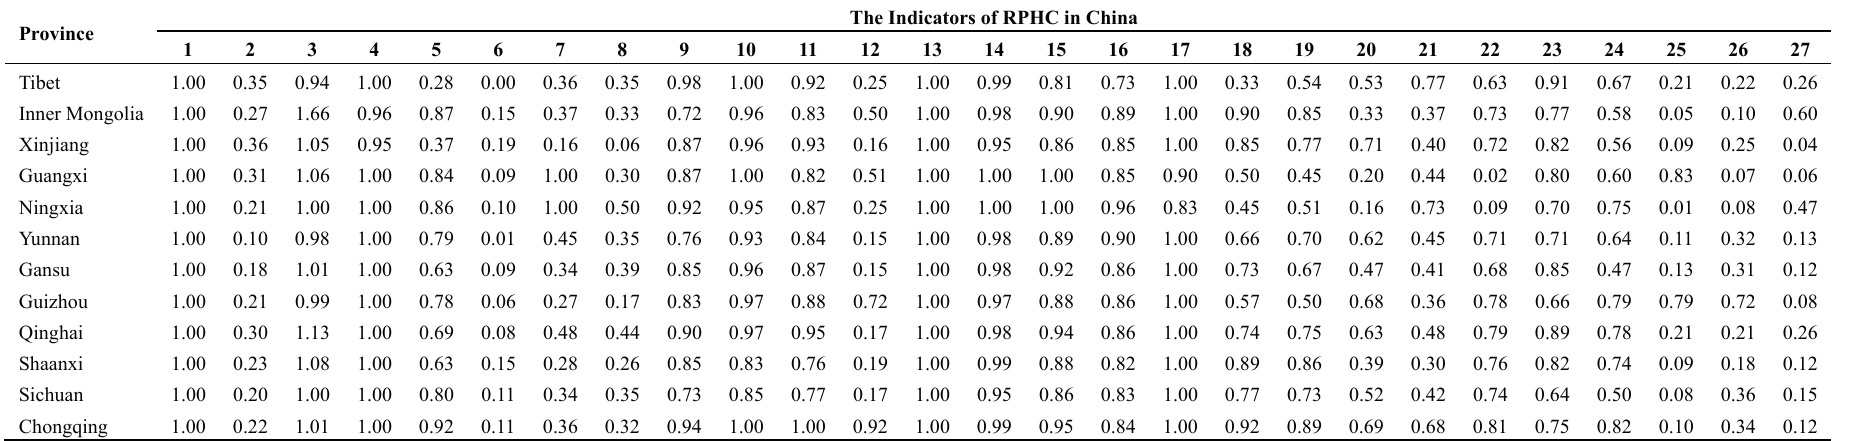
Table 5. The initial matrix of RPHC in 12 Western provinces of